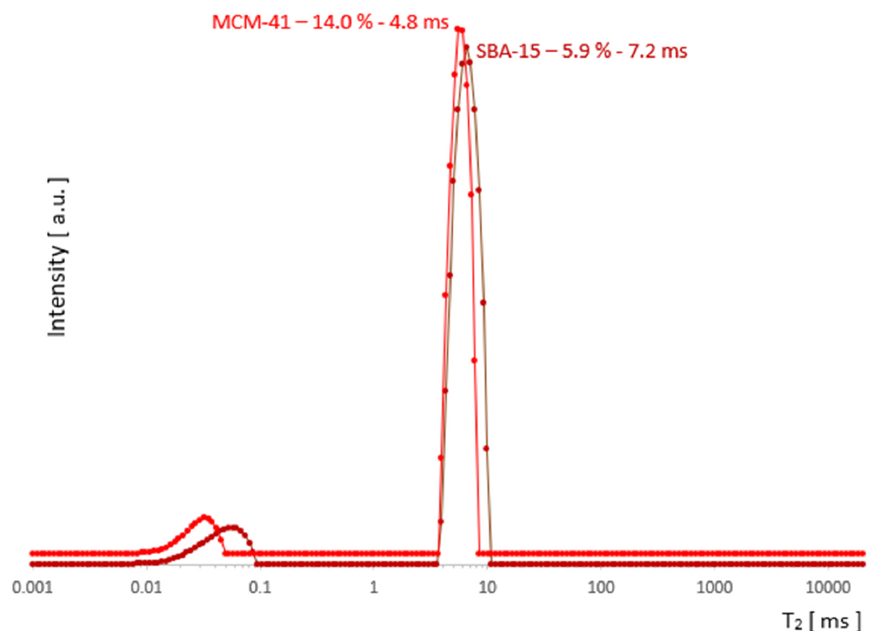
Figure 7. The saturation range for ‘water only in the pores’ (after removal water inter III) begins with the saturation at which the lines for MCM-41 and SBA-15 are similar in width.